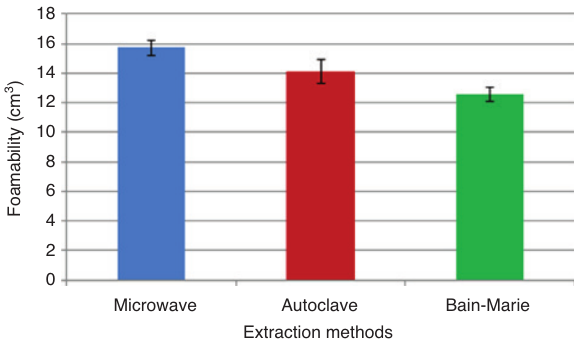
Figure 4: Foam volume generated by shaking the saponin extracts obtained using three different extraction methods. Data are mean values of three replications.